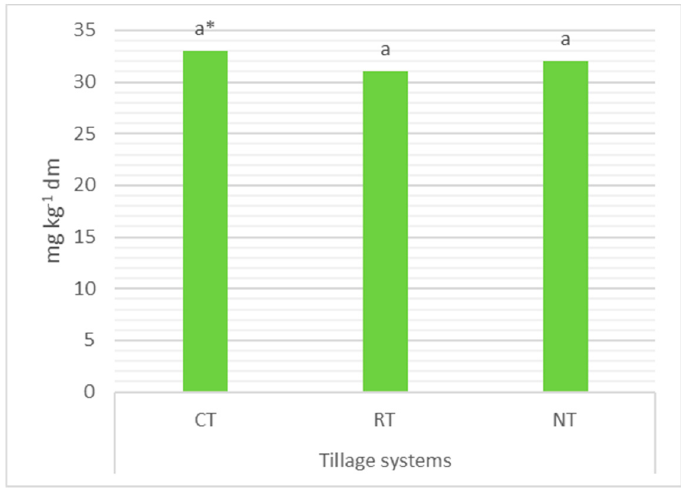
Figure 6. Content of N-NO 3 in the 0–25 cm soil layer depending on the tillage system (average of 2014–2016). * a—Means denoted with the same letters do not differ significantly, p < 0.05.